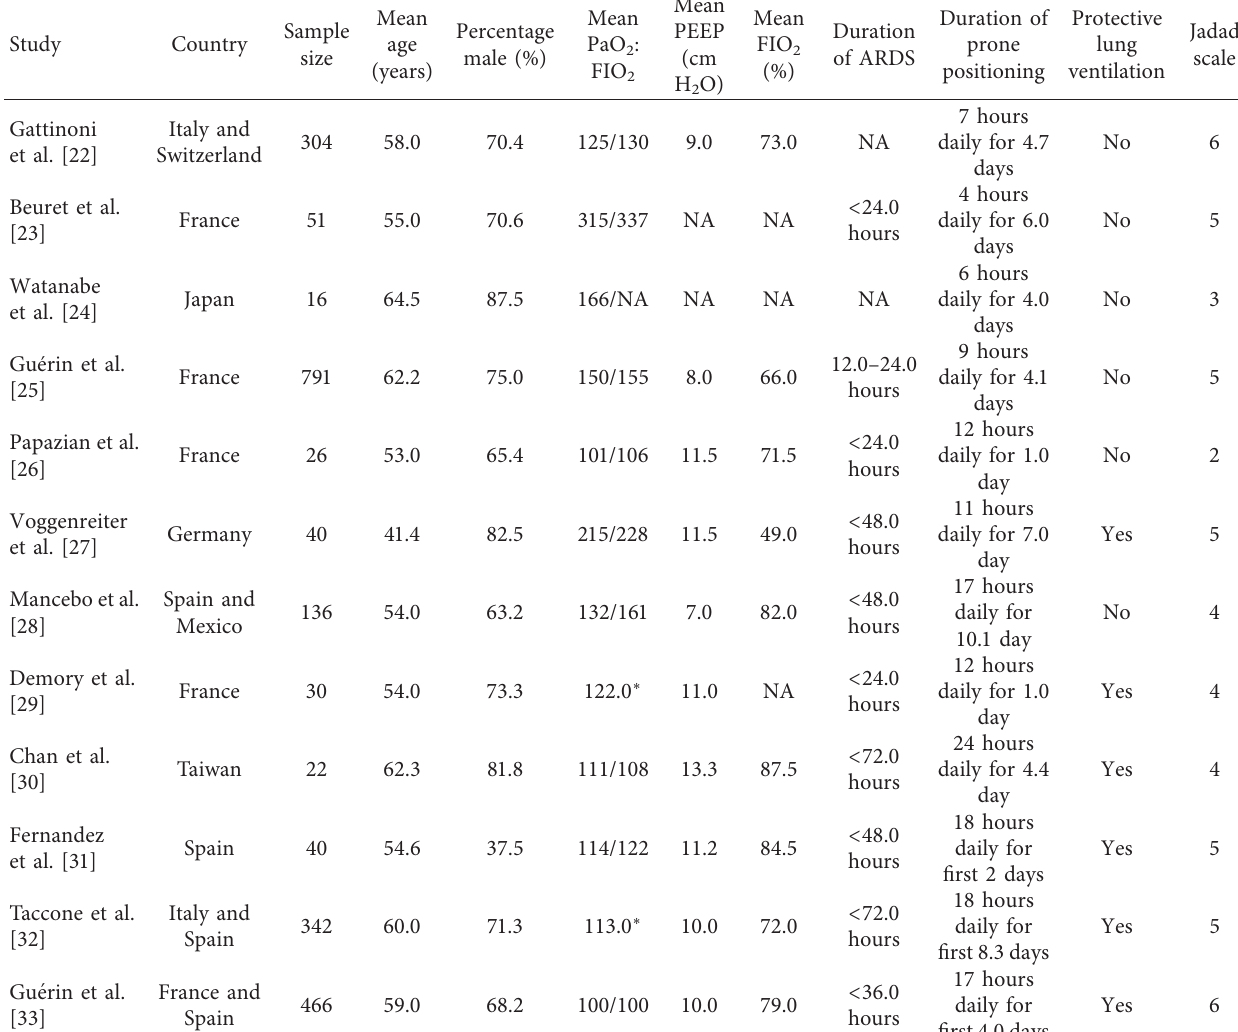
Table 1: Baseline characteristics of the included studies.